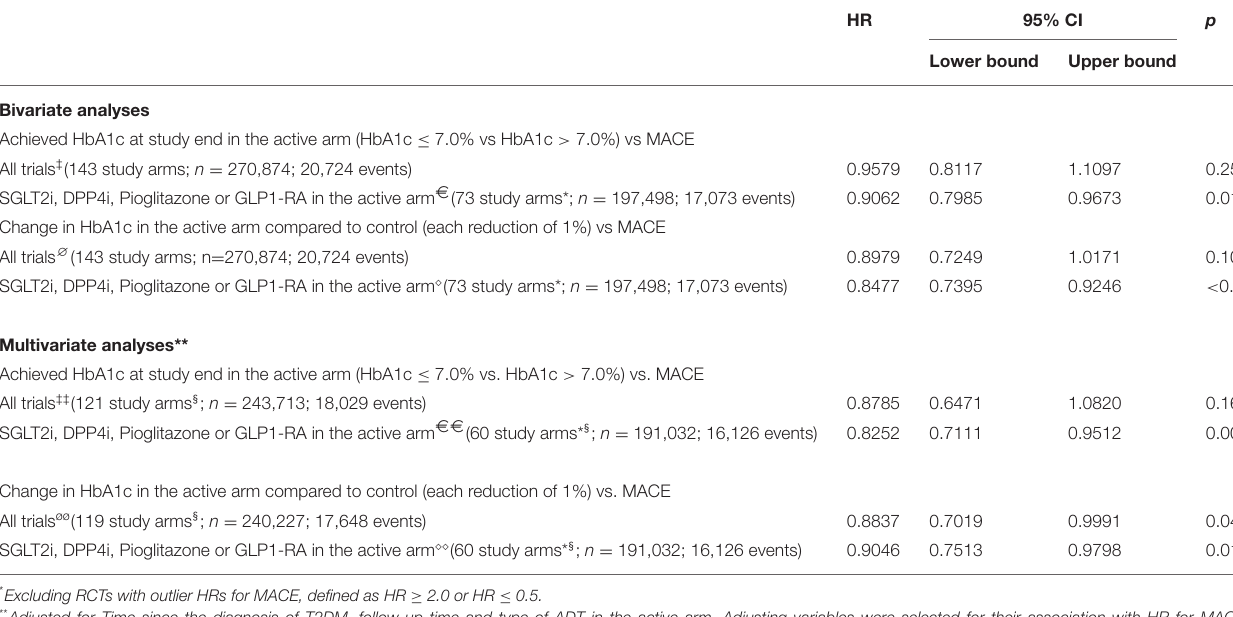
HR 95% CI p Lower bound Upper bound